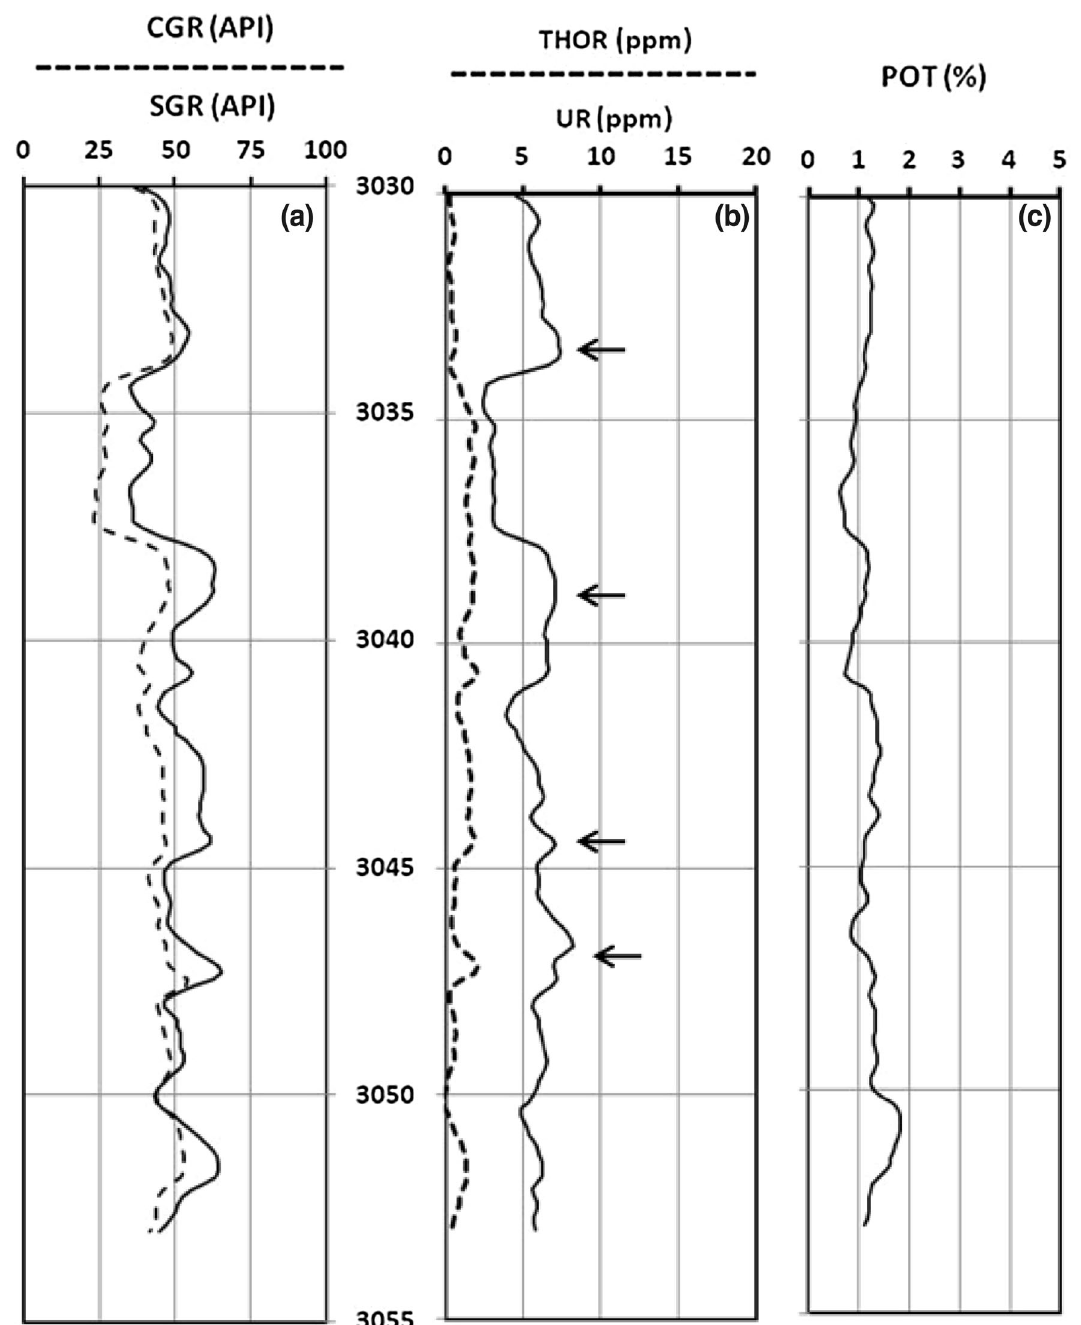
Fig. 9 Fractures probability as indicated from natural gamma ray spectroscopy in Tawila N-1